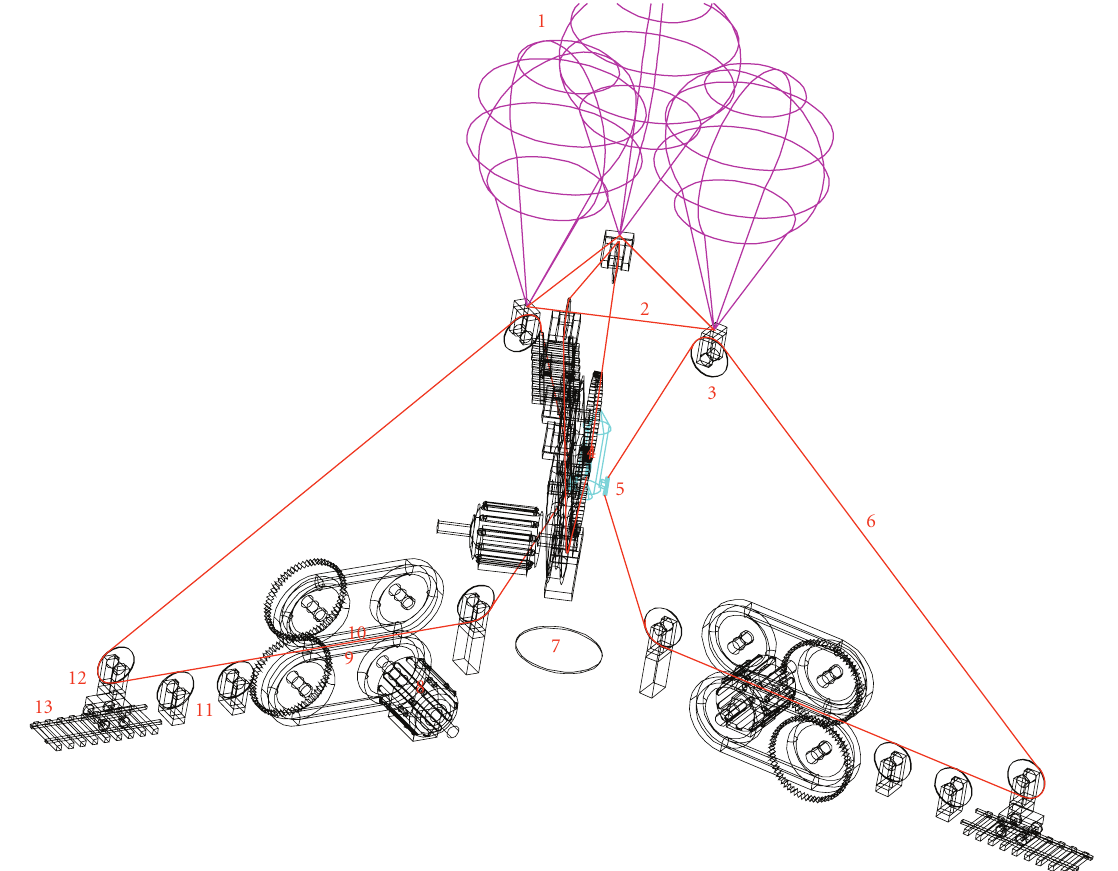
Figure 1: 3D model of the LAS (proportions distorted for clarity) (1): balloons, (2): clustering cable, (3): top block, (4): rocket LVS, (5): rocket attachment points to traction cables, (6): traction cables, (7): launch pad, (8): electric motors, (9): lower coupling belt, (10): upper coupling belt, (11): antisagging towers, (12): tension adjustment block, (13): rails for tension adjustment